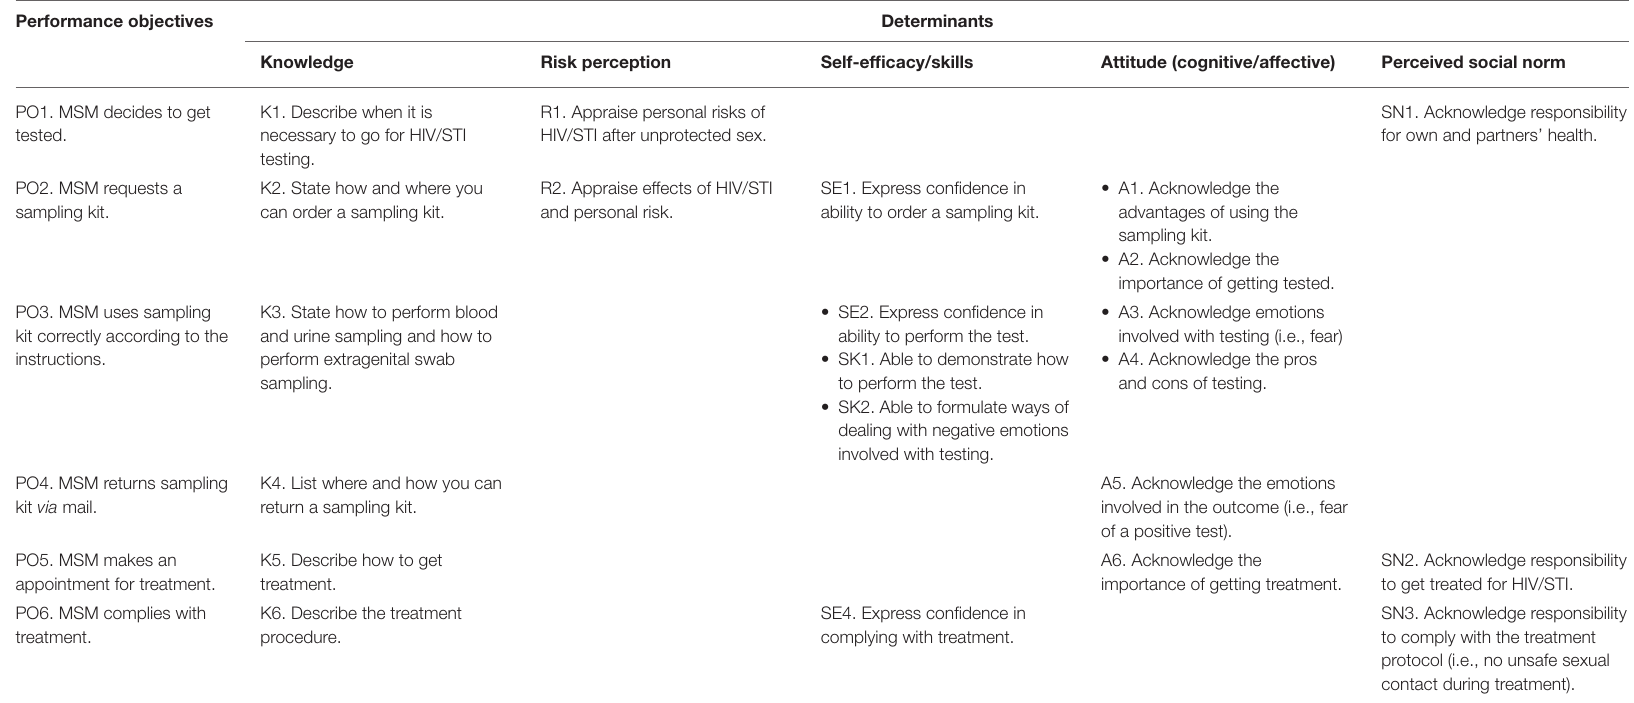
TABLE 1 | Performance and change objectives to promote HIV/STI testing with self-sampling tests among men who have sex with men (MSM). Performance